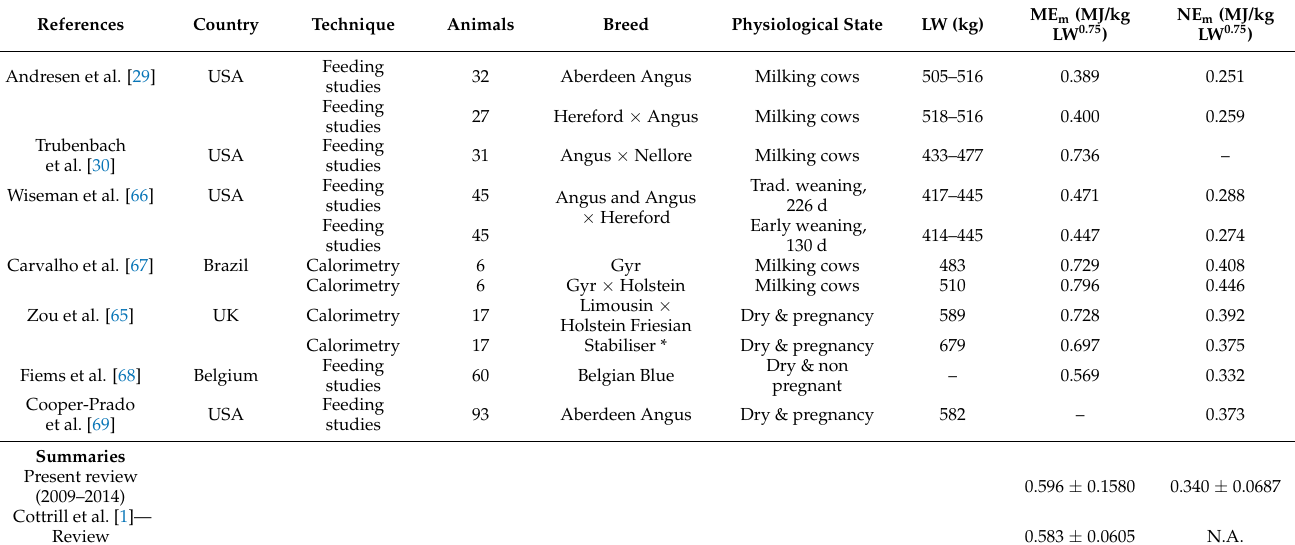
Table 3. Metabolisable and NE requirements for maintenance for suckler cows from recent studies published around the